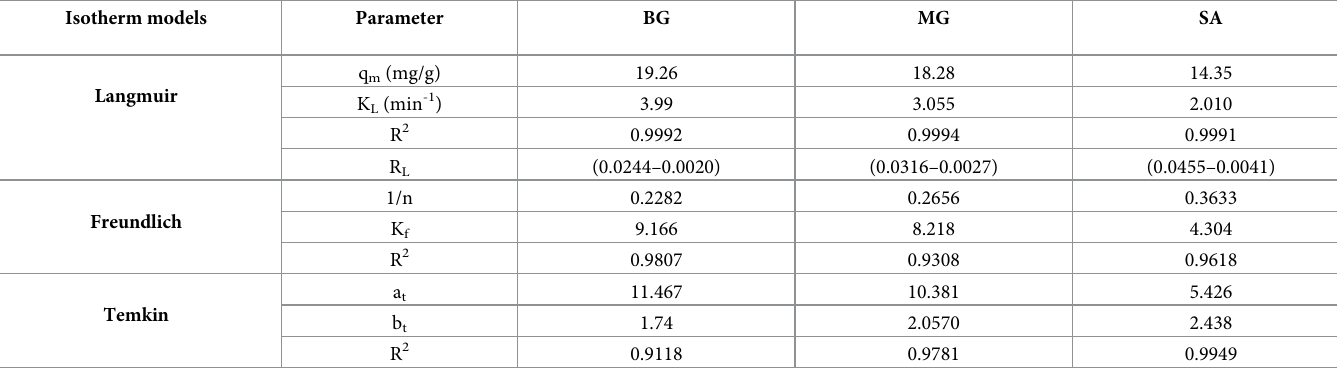
Table 3. The parameters of the Langmuir and Freundlich and Temkin models for dye adsorption onto adsorbent. Isotherm